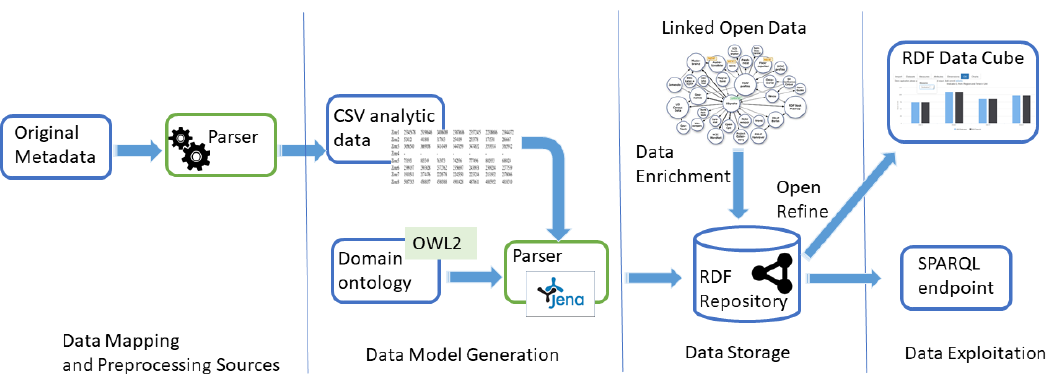
Figure 1. Framework proposal to publish a